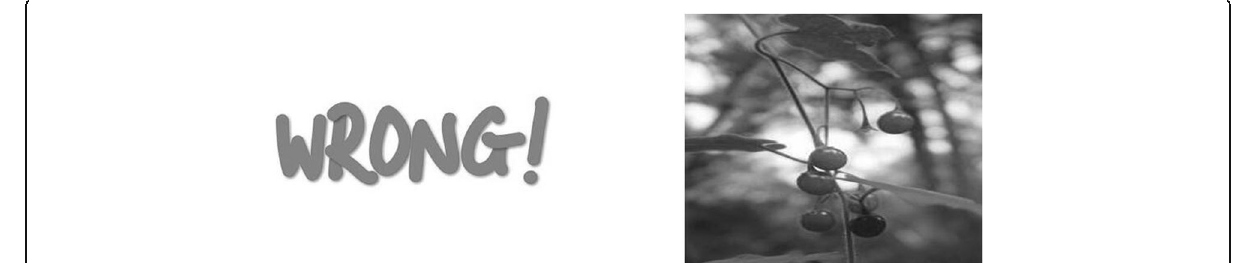
Fig. 8 Embedded carrier image and extracted hidden image